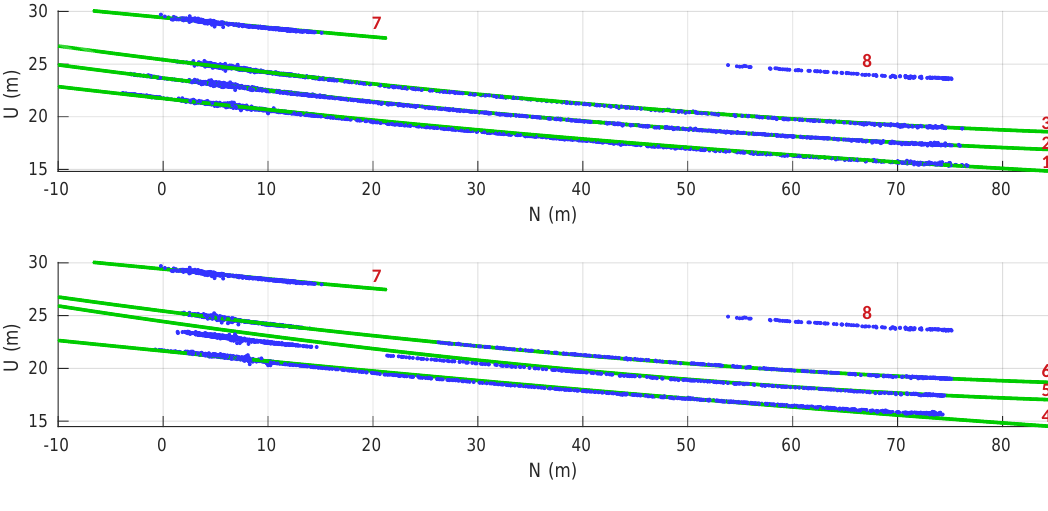
Figure 17. Vertical analysis of estimated power lines.